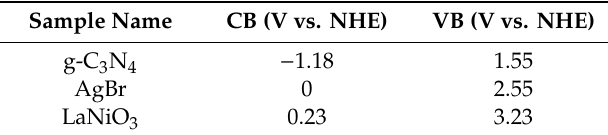
Table 2. The band edge positions of conduction and valence band for the sample g-C 3 N 4 , AgBr and LaNiO 3 (pH = 7) .